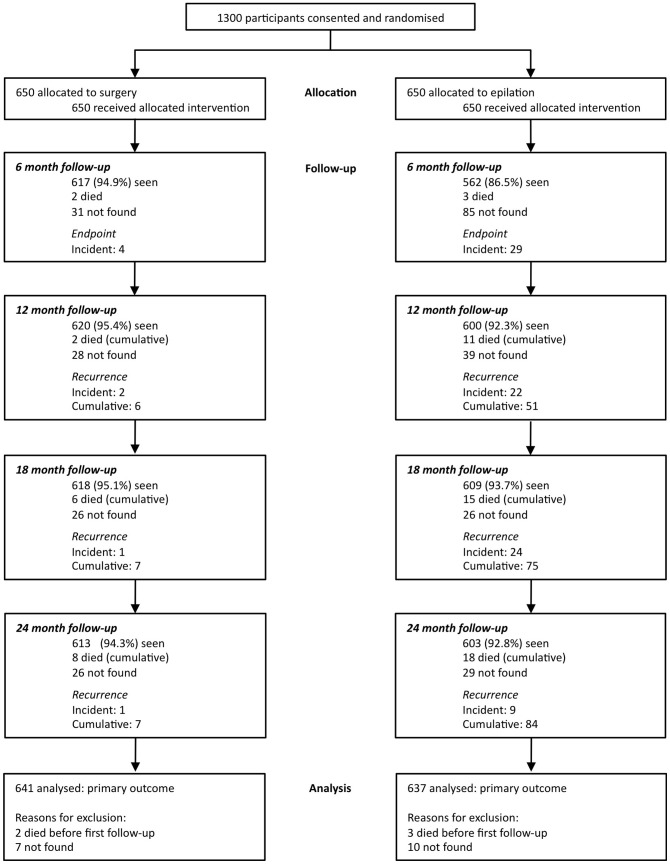
Consort flow chart 2.Surgery versus epilation for the treatment of minor trichiasis in ethiopia: a randomised controlled noninferiority trial. PLoS Med 8: e1001136.